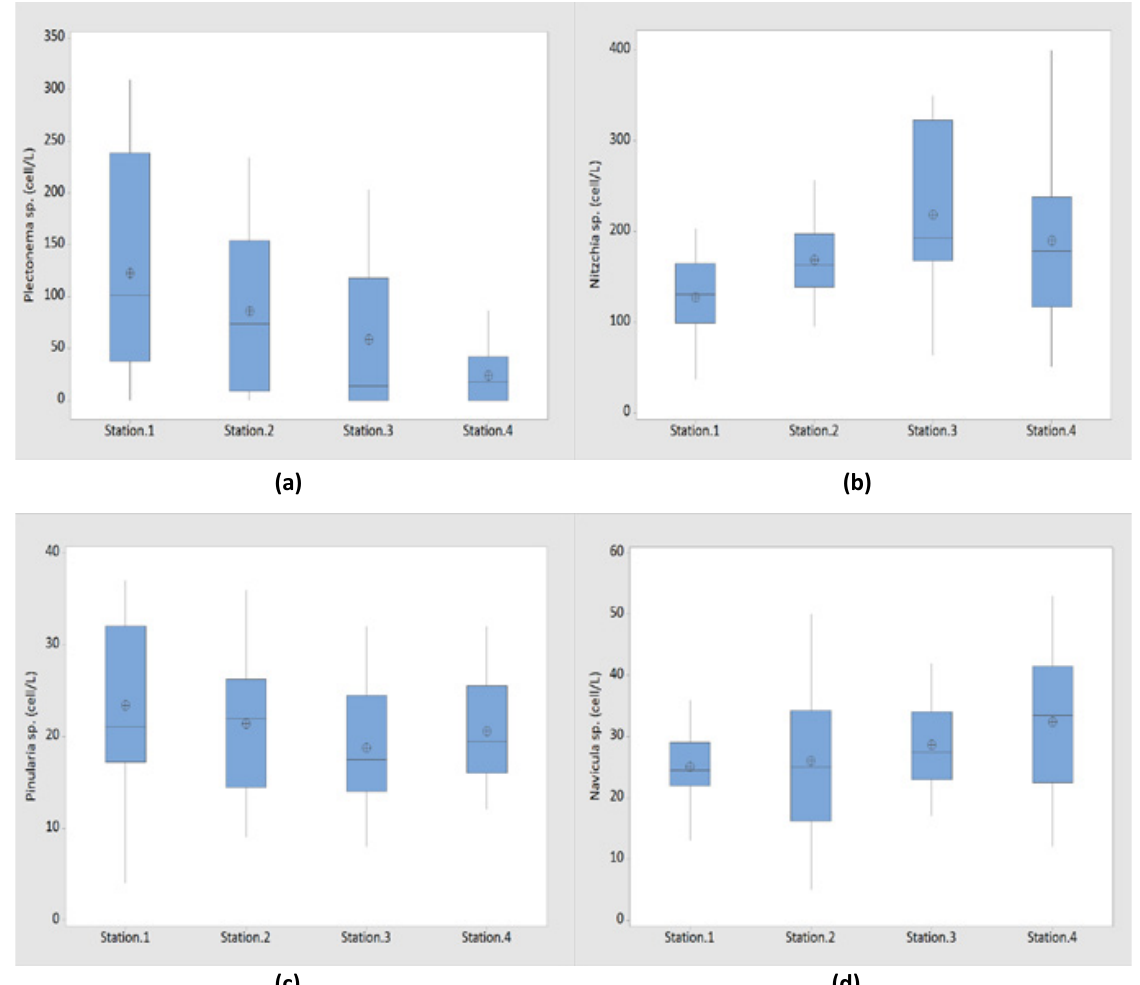
Fig. 8: The average of phytoplankton abundance in the river segment at various station